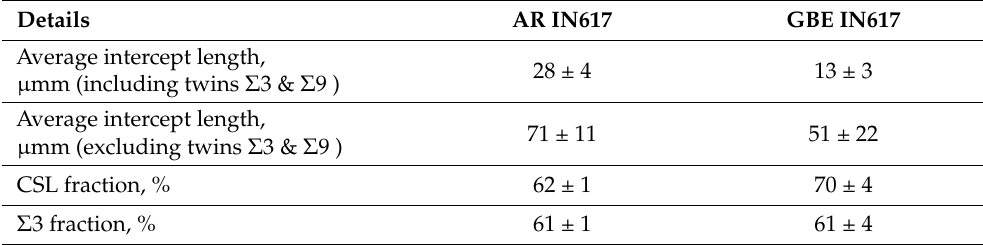
Table 2. Microstructural parameters obtained from EBSD for IN 617.